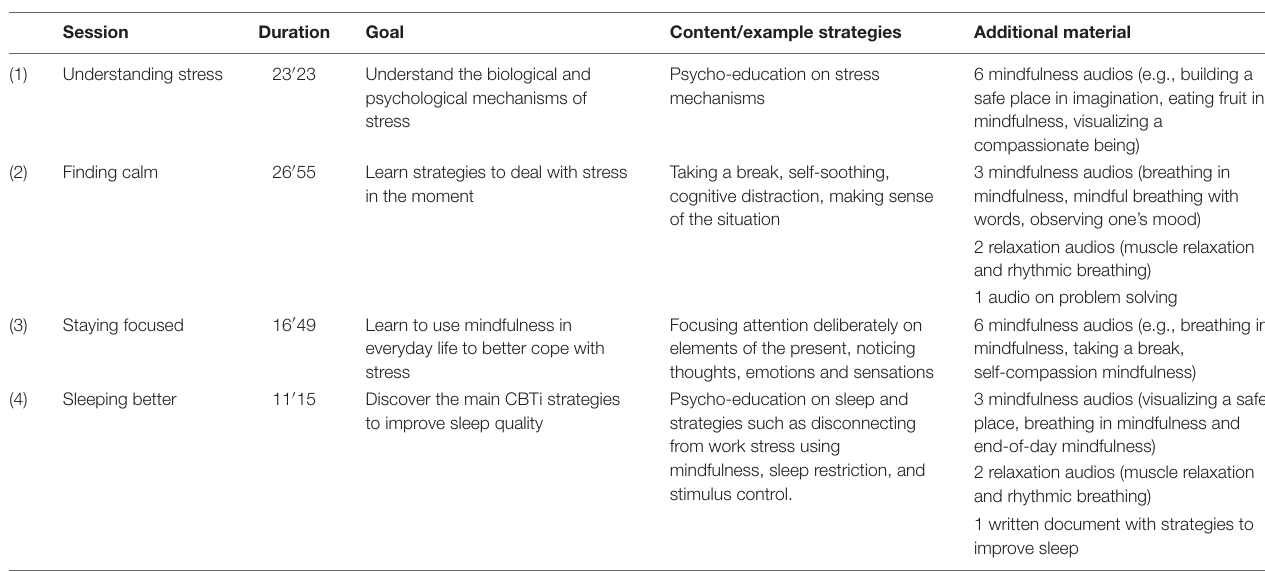
TABLE 2 | Detail of the